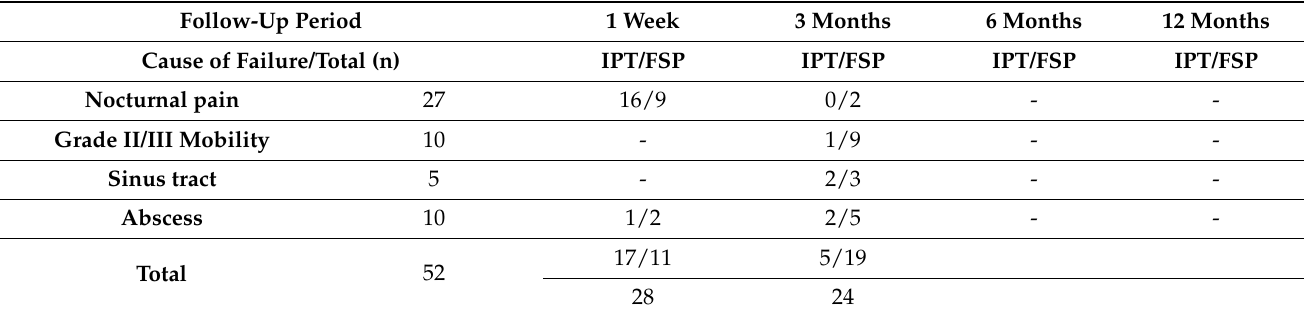
Table 4. Distribution of the clinical sequelae of failed cases of DM based on the clinical manifestation of failure and duration. Follow-Up